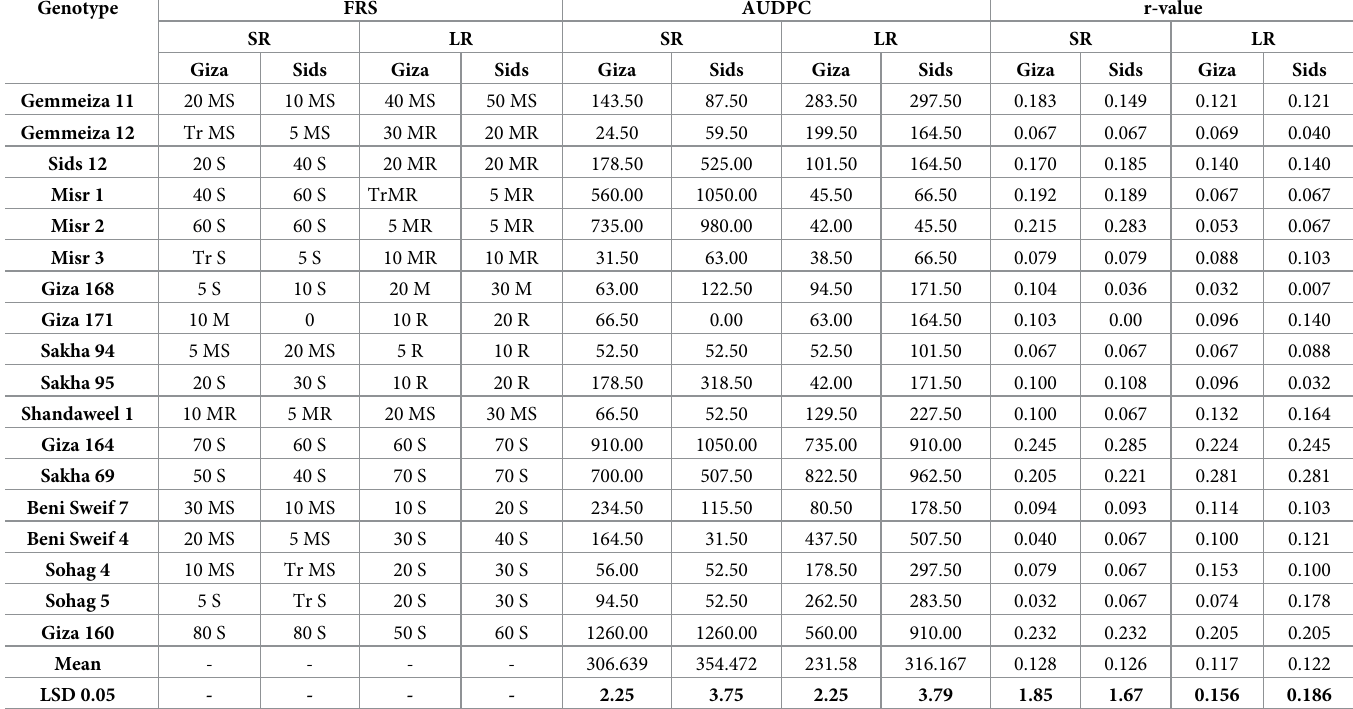
Table 6. Final stem rust severity (FRS %), area under disease progress curve (AUDPC) and rate of rust disease increase (r-value) of 18 wheat genotypes grown at Giza and Sids Agric. Res. Station, during 2020/21 growing seasons.